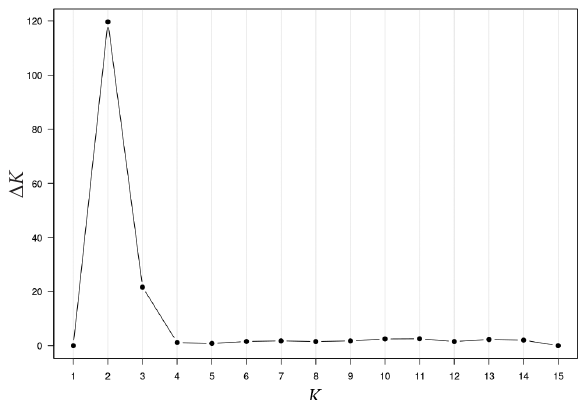
Figure 5. AFLP data-based Bayesian analysis of 15 Lithuanian populations of Lythrum salicaria . Δ K values for K ranging between 1 and